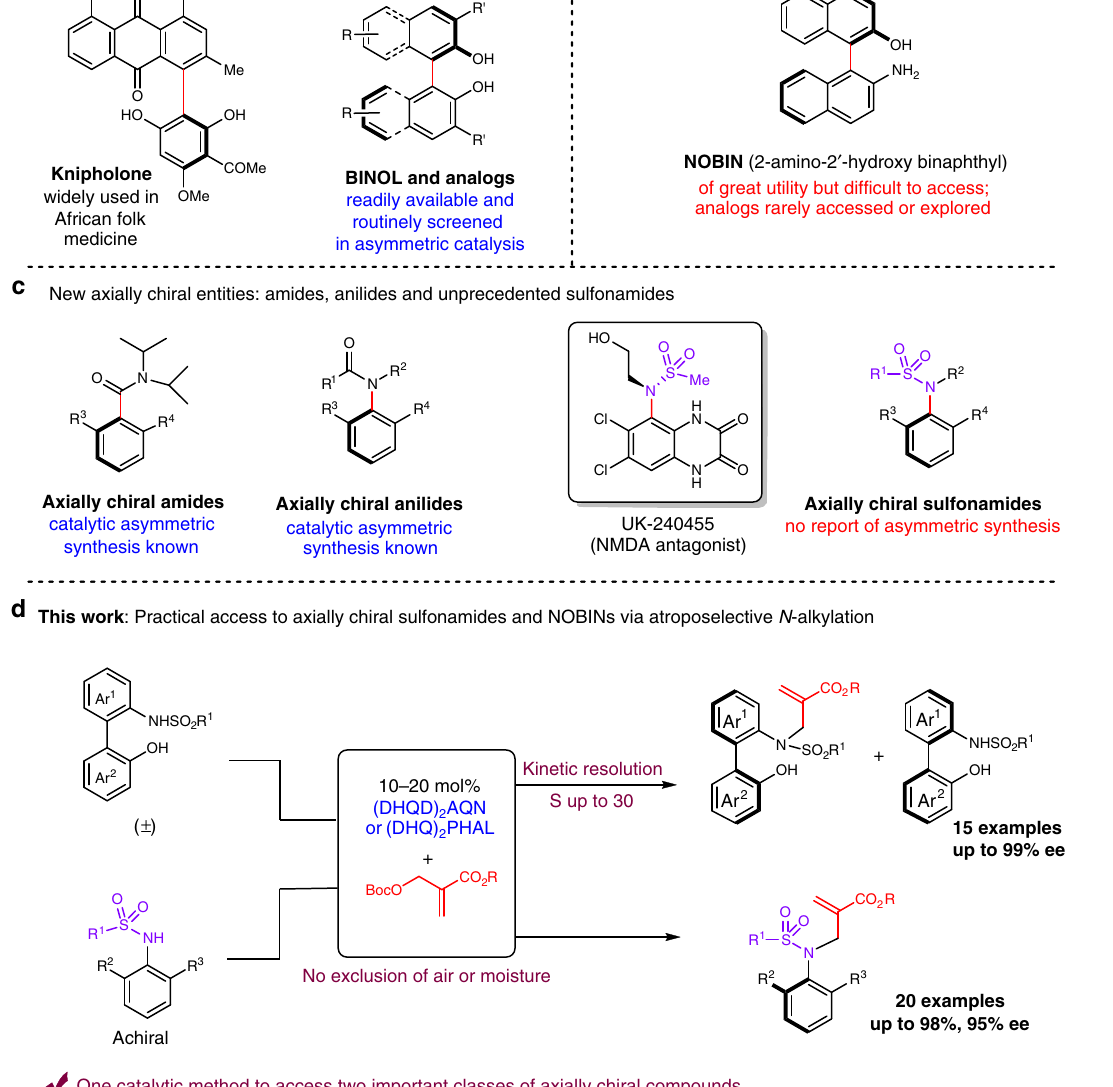
Fig. 1 Application and preparation of various axially chiral entities. a Representative well-established chiral biaryls. b Axially chiral amino alcohol NOBIN. c Other types of axially chiral entities. d Our strategies to axially chiral sulfonamides and NOBINs. BINOL: 1,1 ’